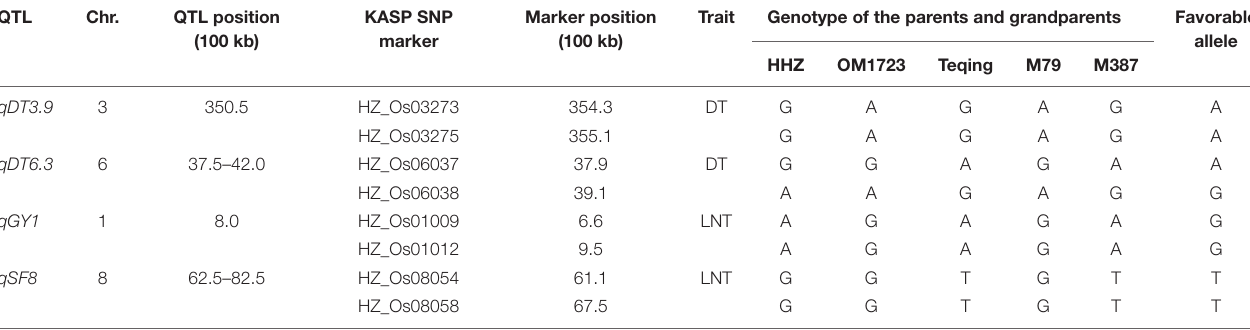
TABLE 3 | Polymorphic KASP SNP genotypes of the parents (M79 and M387) and grandparents (HHZ, OM1723, and Teqing) of the pyramiding cross. QTL Chr.